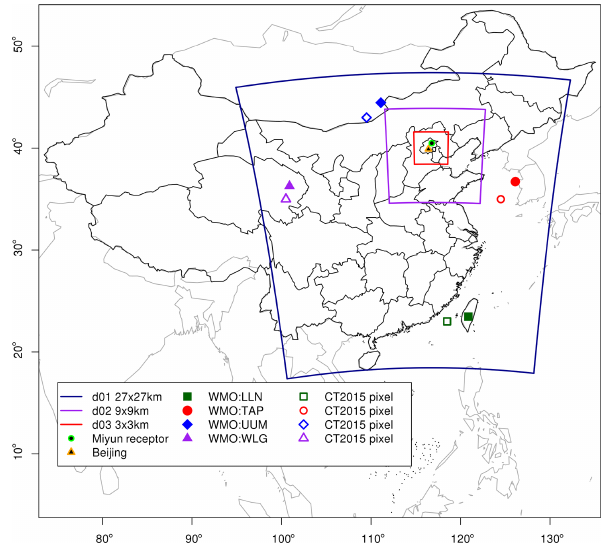
Figure 1. Study domain configuration. Miyun receptor and Bei- jing center are located within the innermost domain at a resolu- tion of 3 × 3km. NOAA ESRL/WMO (WMO) flask sampling sites used to evaluate bias in CT2015 modeled backgrounds are the solid shapes; nearest CT2015 comparison pixel is the corresponding un- filled